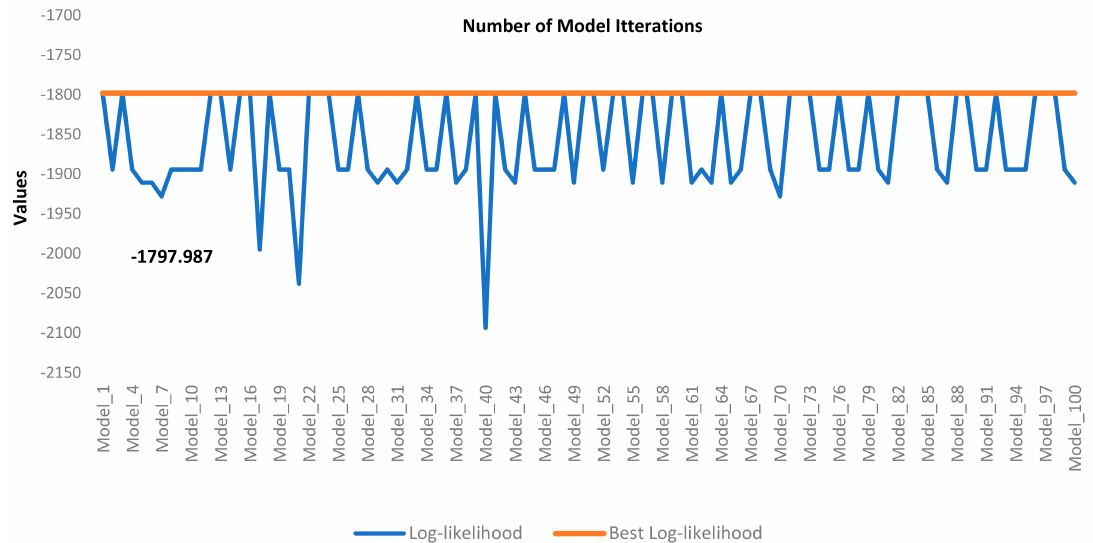
Figure 4. Avoiding local maxima: recognizing LCA model with greatest log-likelihood